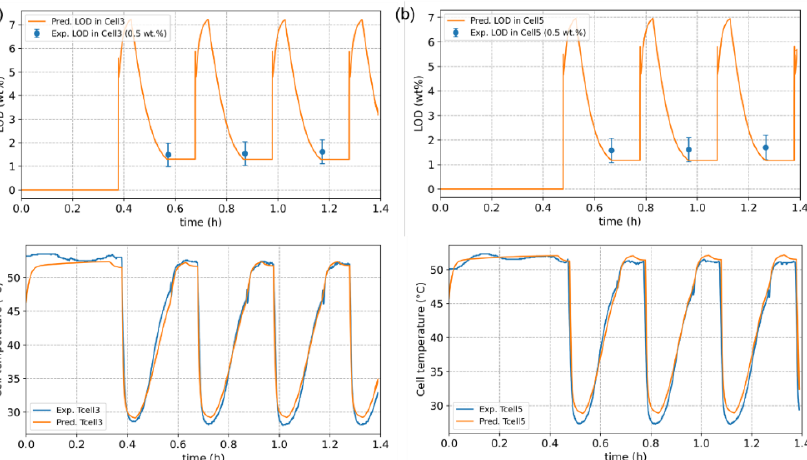
Figure 11. Comparison of experimental and predicted cell temperatures and LOD values from soft sensing in ( a ) Cell3 and ( b ) Cell5, respectively.